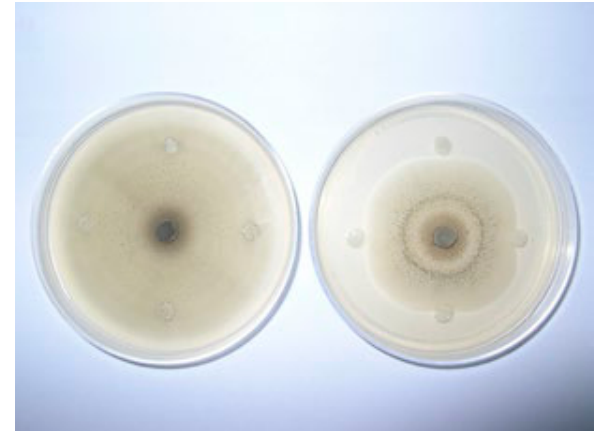
Figure 6. Effect of nerolidol on Pm. parasiticum growth in a Petri dish with 15 mL of malt extract agar (right) and Pm. parasiticum growth without nerolidol